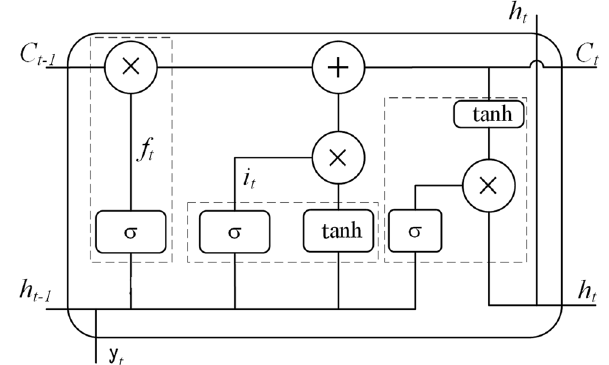
Fig. 1 The Structure of